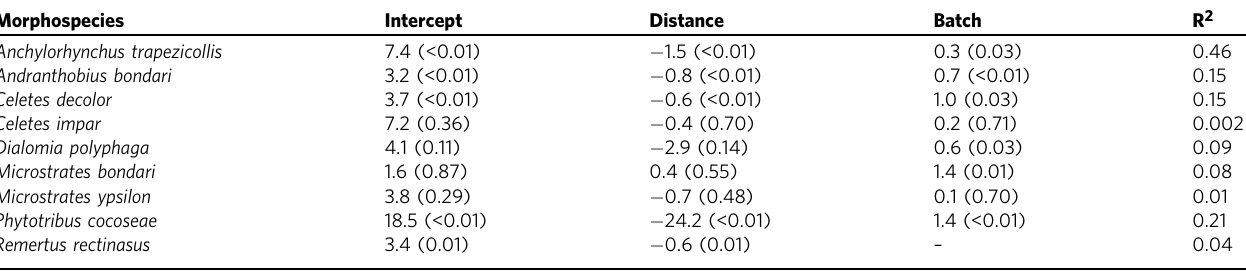
Table 2 Effect of nucleotide distance and shared library batch on number of shared RAD loci (thousands). Morphospecies Intercept Distance Anchylorhynchus trapezicollis